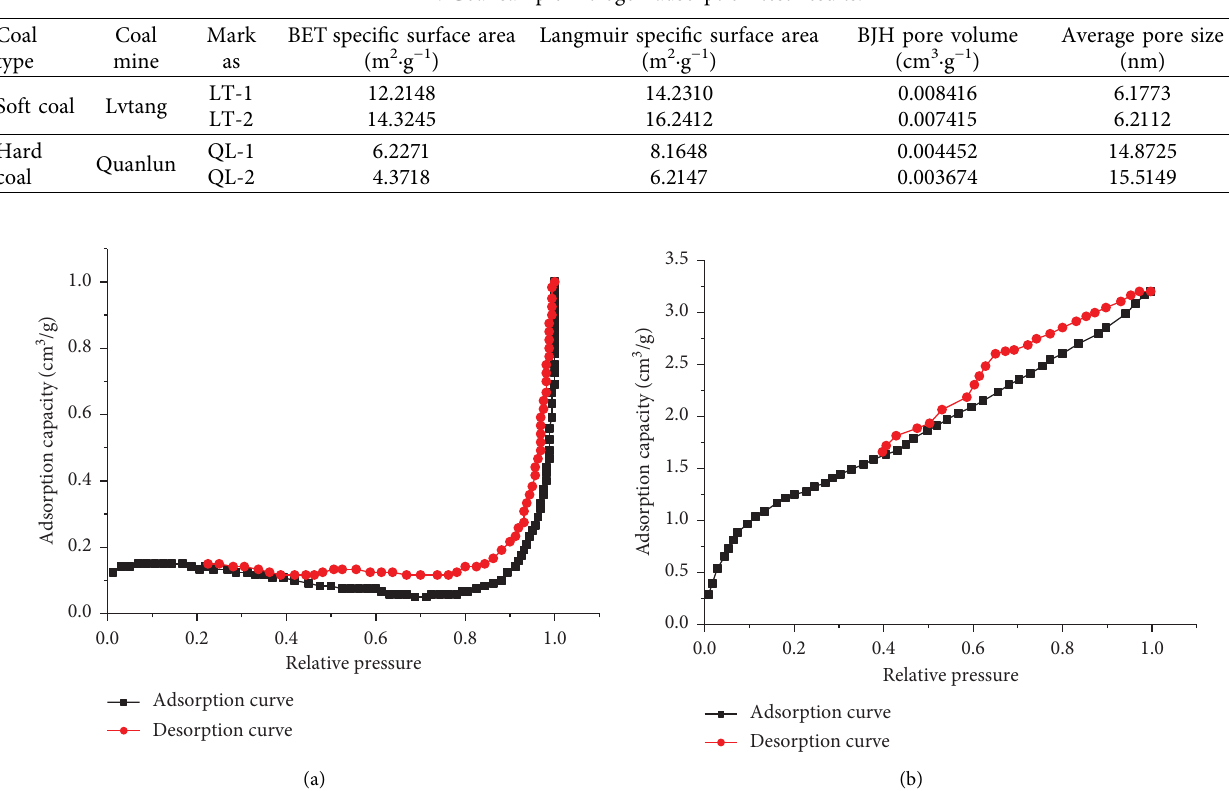
Figure 5: Low-temperature nitrogen adsorption/desorption curve of coal sample. (a) Soft coal. (b) Hard coal.